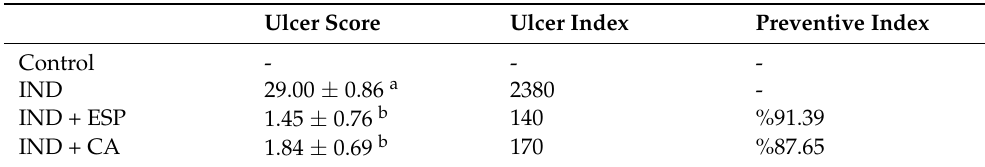
Table 1. Effects of CA on IND-induced macroscopic gastric injuries. Ulcer Score, Ulcer Index and Effect of Carnosic acid (Preventive